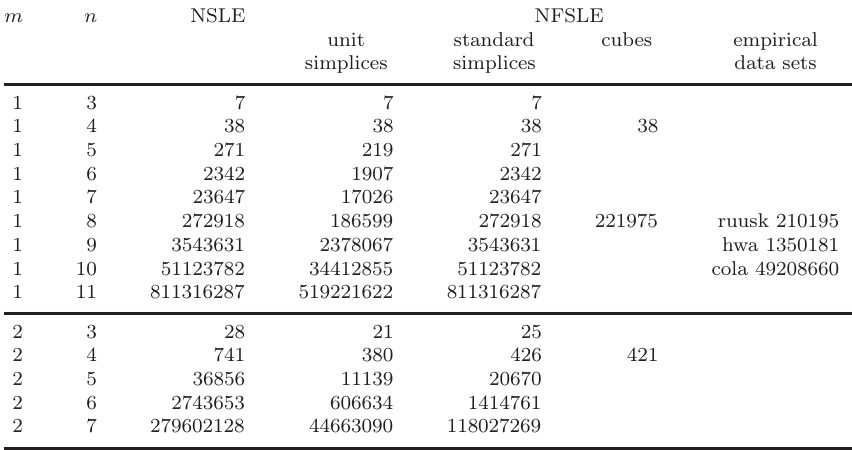
Table 2. The numbers of feasible lower level